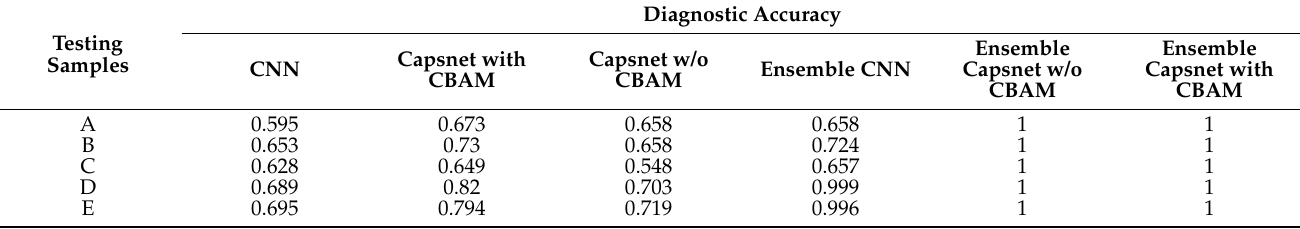
Table 5. The diagnostic accuracy of six diagnostic models for different